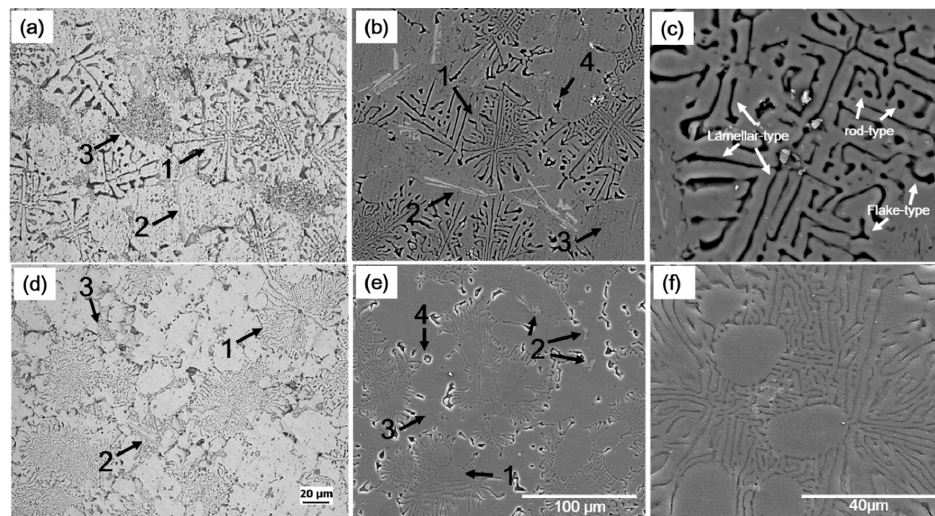
Figure 1. As-cast microstructures of unmodified (A1) and modified (E1) alloys; ( a , d ) are optical micrographs of A1 and E1 alloy, respectively. Whereas ( b , c ) are SEM micrographs of A1 alloy at different magnifications, and ( e , f ) are showing SEM micrographs of E1 alloy at varying magnifications. Here 1, 2, 3, and 4 indicate the binary eutectic Al–Mg2Si phases, iron-bearing phases, ternary eutectic Al–Mg2Si–Si phases, and primary Mg2Si phases,